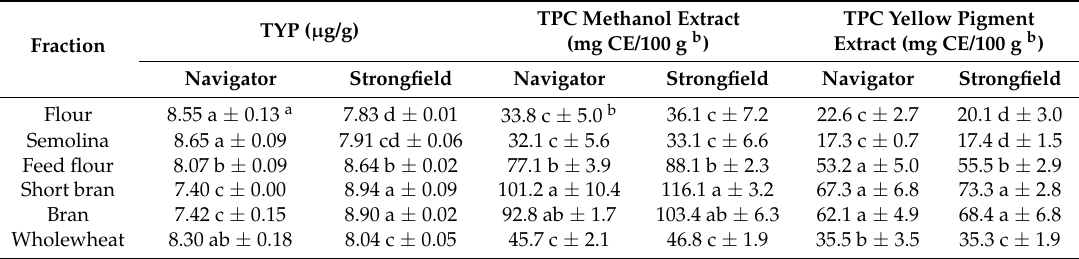
Table 1. Total yellow pigment (TYP) content, total phenolic content (TPC) of methanol, and yellow pigment extracts of milling